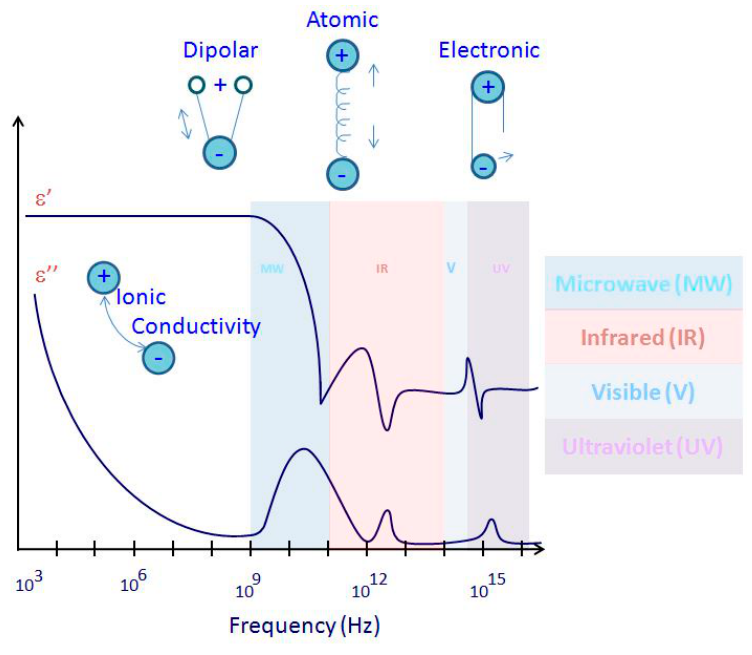
Figure 2. Polarization mechanisms versus the frequency range.